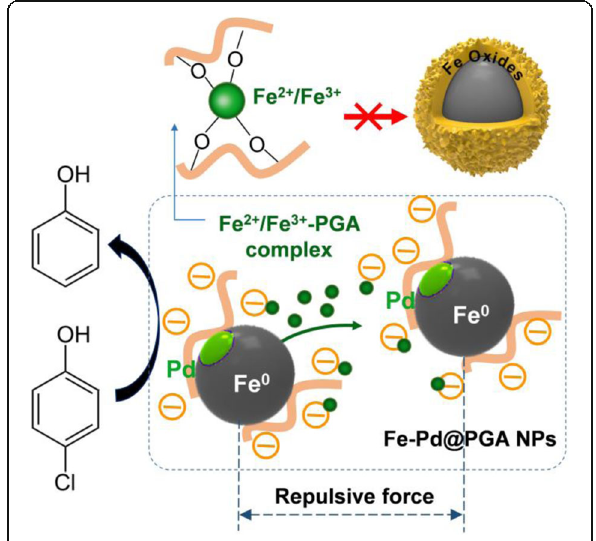
Fig. 6 Mechanism of the enhanced dechlorination of p -CP